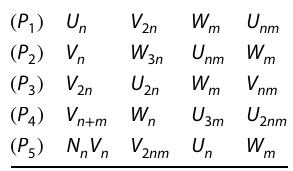
Table 1 Substitution